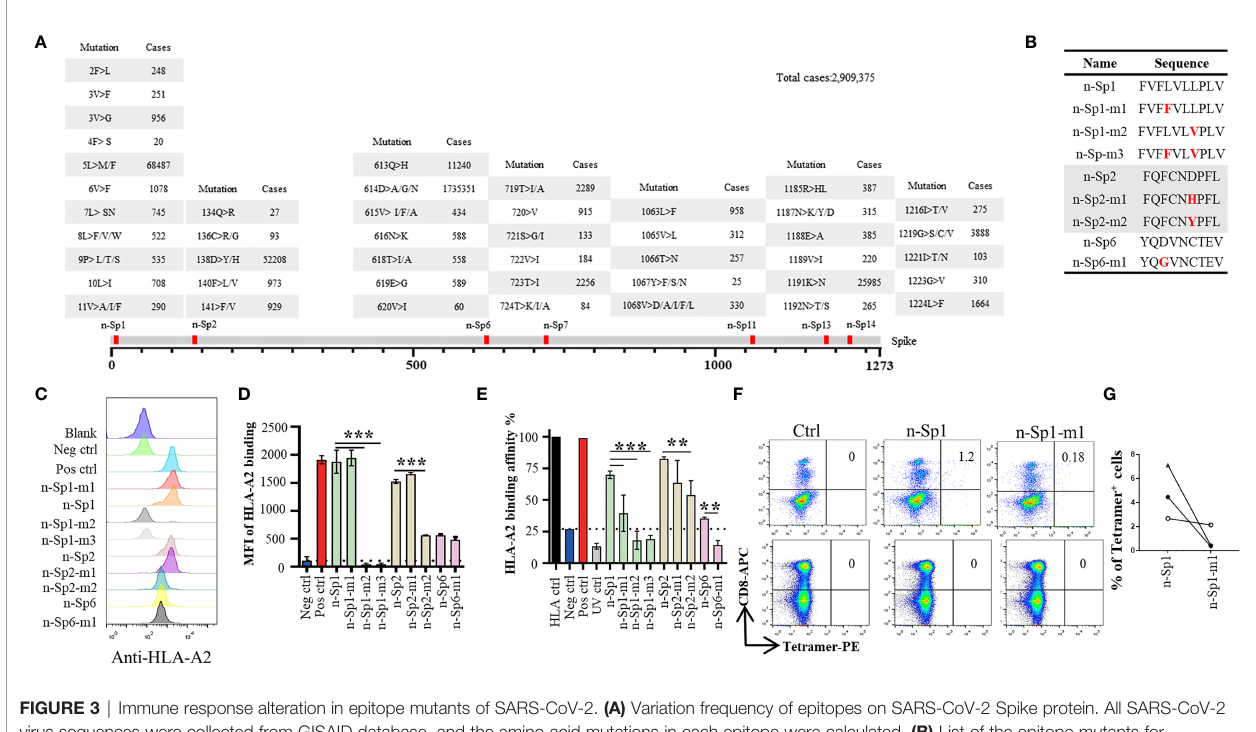
FIGURE 3 | Immune response alteration in epitope mutants of SARS-CoV-2. (A) Variation frequency of epitopes on SARS-CoV-2 Spike protein. All SARS-CoV-2 virus sequences were collected from GISAID database, and the amino acid mutations in each epitope were calculated. (B) List of the epitope mutants for subsequent experiments. Comparison of epitope mutant binding to HLA-A2 in T2 cells. Wild-type and mutated epitopes were synthesized and incubated with T2 cells. (C, D) The peptide binding on T2 cells was measured with anti-HLA-A2 staining fl ow cytometry. (D) Values indicate the stabilized HLA-A2. Blank: no peptides; Neg ctrl, negative control; Zika virus peptide (P30-38 GLQRLGYVL), Pos ctrl: positive control; in fl uenza A M1 peptide (M58-66 GILGFVFTL). (E) Comparison of epitope mutant binding to HLA-A2 by ELISA assay. Peptide exchange assay was performed with coated UV-sensitive peptide/MHC complex and given peptides. The binding capability was measured with anti-HLA-A2 ELISA assay. Blank: no peptides; HLA ctrl: UV-sensitive peptide without UV irradiation; Neg ctrl: negative control, Zika virus peptide (P30-38 GLQRLGYVL); Pos ctrl, positive control; in fl uenza A M1 peptide (M58-66 GILGFVFTL); UV ctrl, UV-sensitive peptide with UV irradiation. (F, G) Measurement of n-Sp1- and n-Sp1-m1-speci fi c CD8 + T cells in HLA-A2 convalescent COVID-19 patients with fl ow cytometry. (G) Values indicate the percentage of tetramer + T cells, n = 3. Ctrl, tetramer with UV-sensitive peptide. The data are represented as the mean ± SD in three independence experiments, ** p ≤ 0.01; **** p ≤